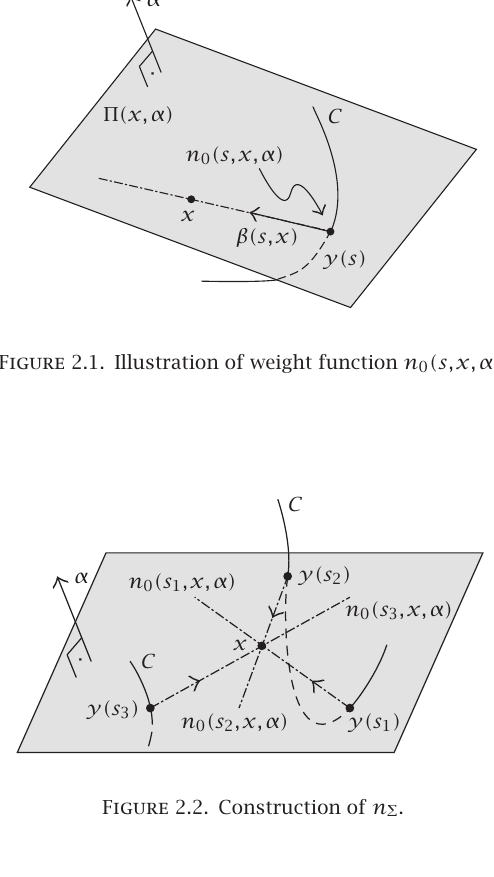
Figure 2.2 . Construction of n Σ